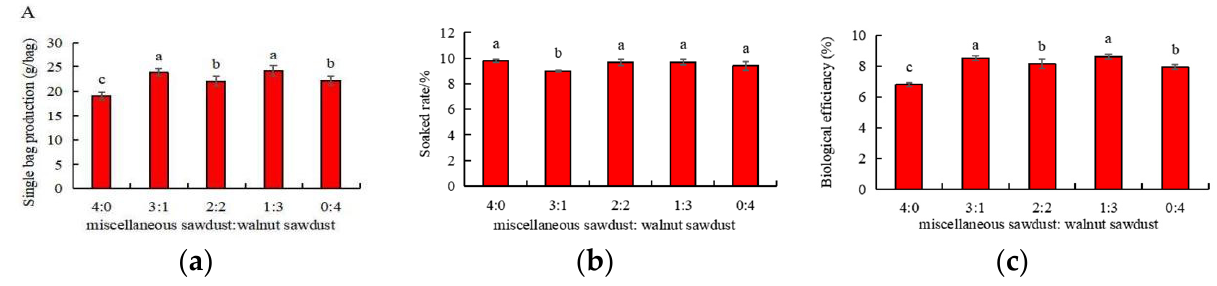
Figure 5. Effects of different proportions of walnut sawdust on single bag production ( a ), soaked rate ( b ) and biological efficiency ( c ) of A. auricula basidiocarp. Different lowercase letters within each column are significantly different at p < 0.05 between treatments.